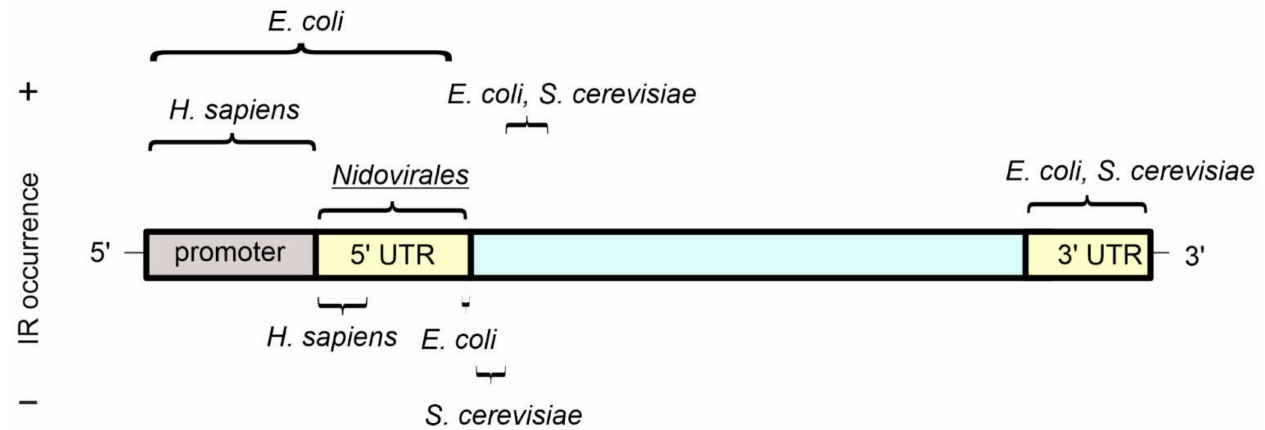
Figure 3. The occurrence of inverted repeat sequences in gene features as determined by bioinfor- matic analyses. An idealised gene and its regulatory sequences are shown, with UTR referring to “untranslated regions”. A relative abundance (+) or depletion ( − ) of inverted repeats in the indicated genomes is highlighted above and below the idealised gene, respectively. For E. coli and S. cerevisiae , inverted repeats with a stem length from 5 bp and a spacer length up to 8 bp were considered [50,51], while for H. sapiens and viruses from the Nidovirales order, inverted repeats with the stem length from 6–30 bp and spacer length up to 10 bp were taken into account